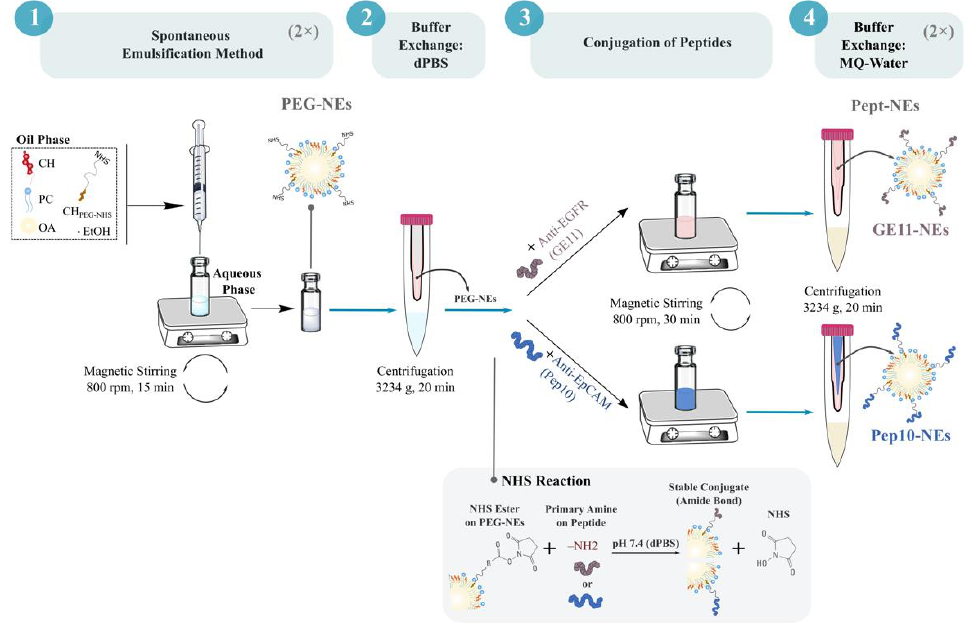
Figure 2. Schematic representation of the formulation procedure to obtain the Pept-NEs (GE11-NEs and Pep10-NEs). The four main steps in the procedure are: (1) spontaneous emulsification, performed twice (2 × ) to obtain 2 mL of PEG-NEs; (2) buffer exchange from MQ-water to dPBS; (3) conjugation of peptides using 1 mL of PEG-NEs for each peptide (the chemical reaction is represented in the grey box), and (4) performing a second buffer exchange, from dPBS to MQ-water, followed by storage.